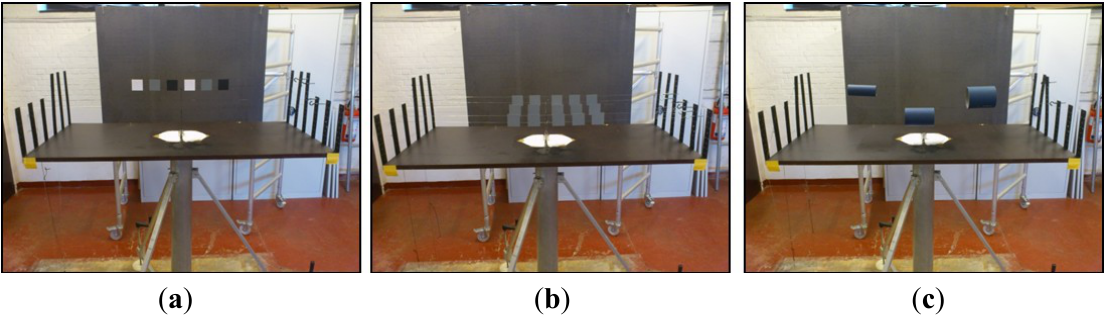
Figure 1. Measurement setups with canopy-like structures installed on the rotating platform. ( a ) The leaves setup showing the dimensions of the setup and six objects with reflectance values (left to right): 10%, 50%, 90%, 10% 50% 90%; ( b ) The layers setup showing 15 objects with reflectance value of 50%; ( c ) the branches setup showing three objects with a reflectance value of